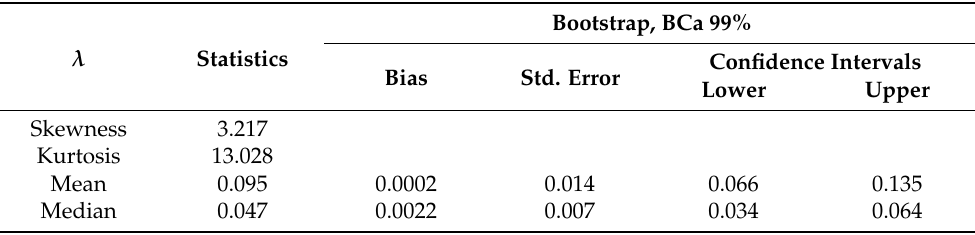
Table 2. Inferential statistics results of derived λ for M80 decadal dataset at α = 0.01.